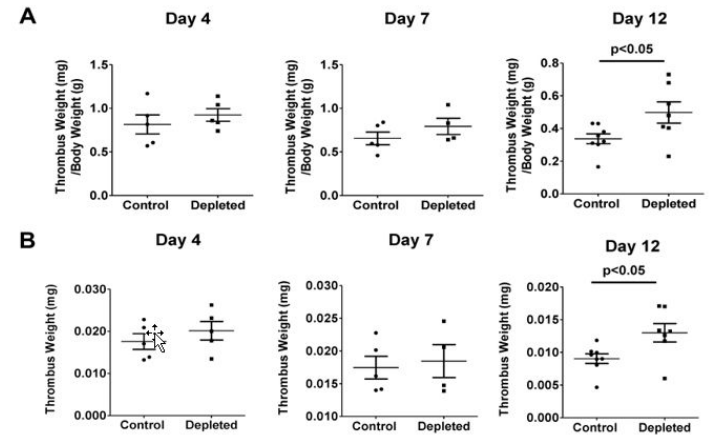
Figure 3. Depletion of T cells impairs venous thrombus resolution. ( A ) Thrombus weight normalized to mouse body weight over time after vena cava ligation in T cell depleted mice compared to control mice (Day 4 n = 5, Day 7 n = 4–5, Day 12 n = 7–8). ( B ) Thrombus weight over time after vena cava ligation in T cell depleted mice compared to control mice (Day 4 n = 5, Day 7 n = 4–5, Day 12 n = 7–8).